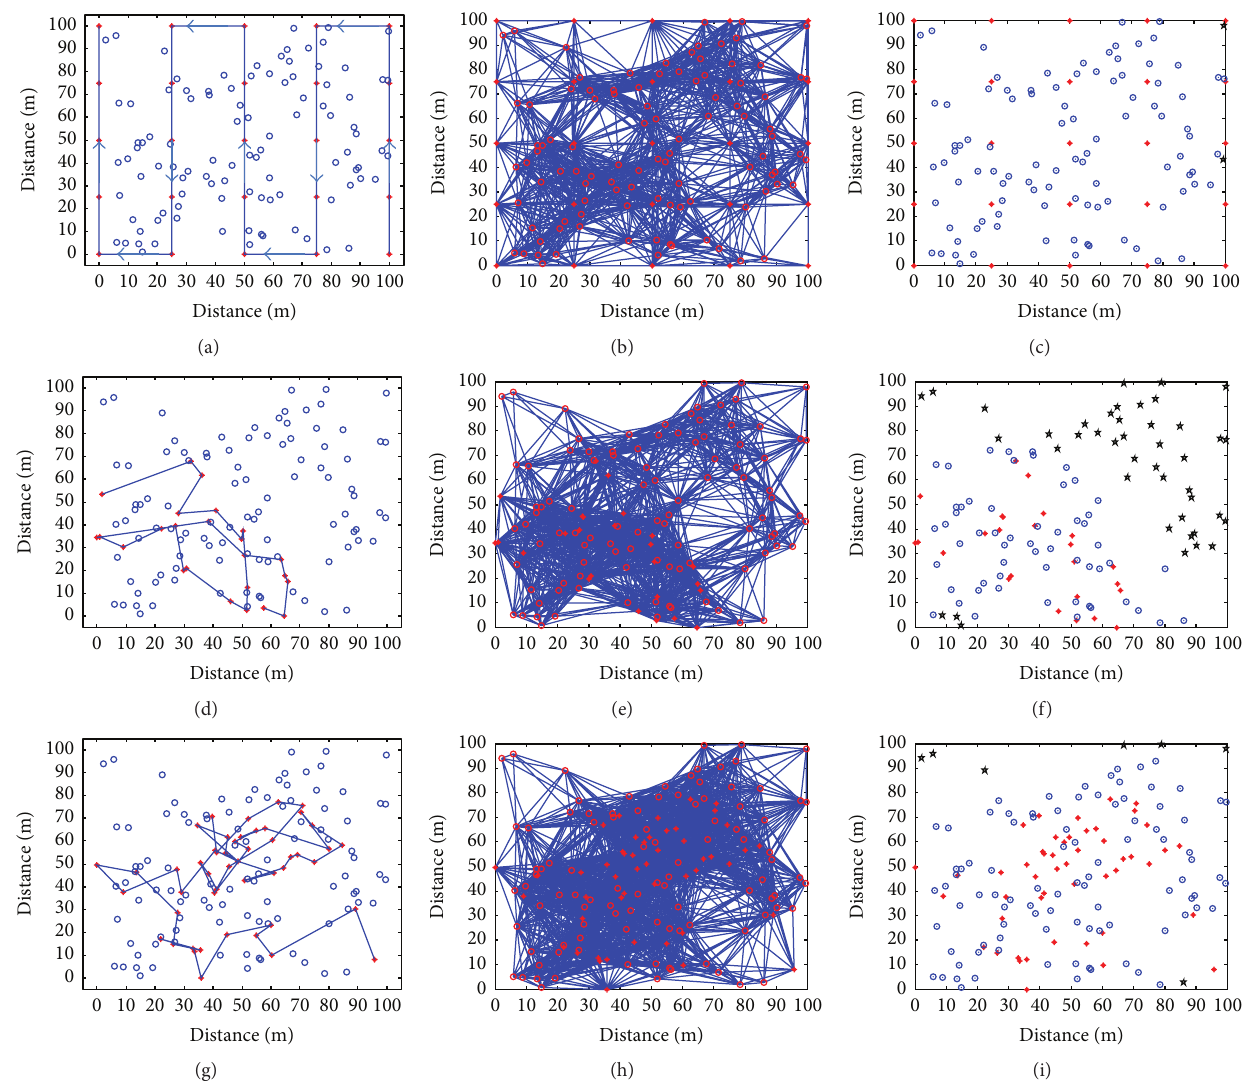
Figure 9: Contrast of difference mobile paths ((a) is the mobile path of grid scan in 25 virtual nodes. (d) and (g) are the mobile path with RWP in 25 and 50 virtual nodes, resp. (b), (e), and (h) are the neighbor relationship of nodes in conditions of grid scan and RWP, resp. (c), (f), and (i) are the localization error in conditions of grid scan and RWP resp. The communication radius is always 30